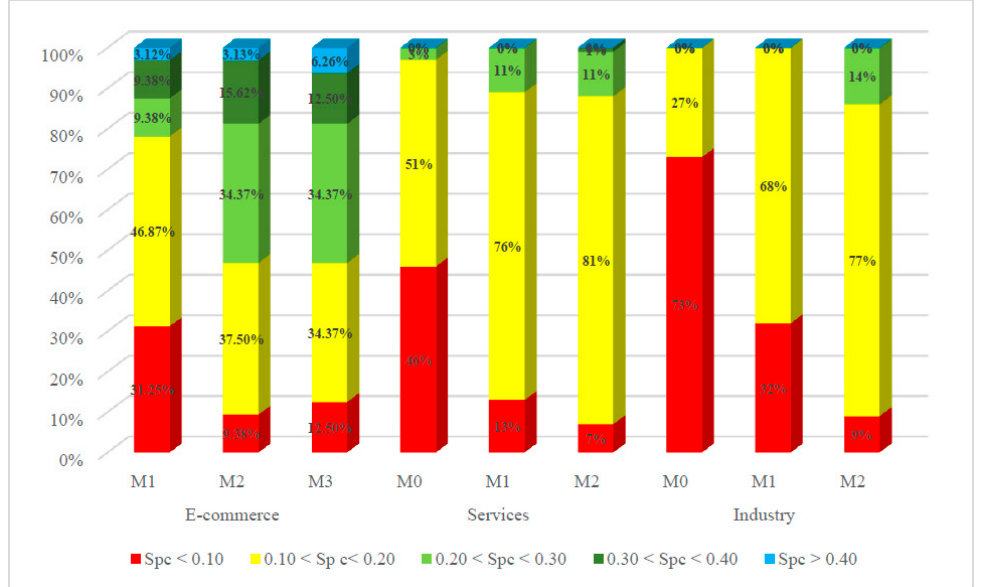
Figure 3. Spc structure on the three sectors for each moment (before/after implementation). (Note: M0 represents the moment before implementation and from M1 to M2; M3 represents the moment after implementation).